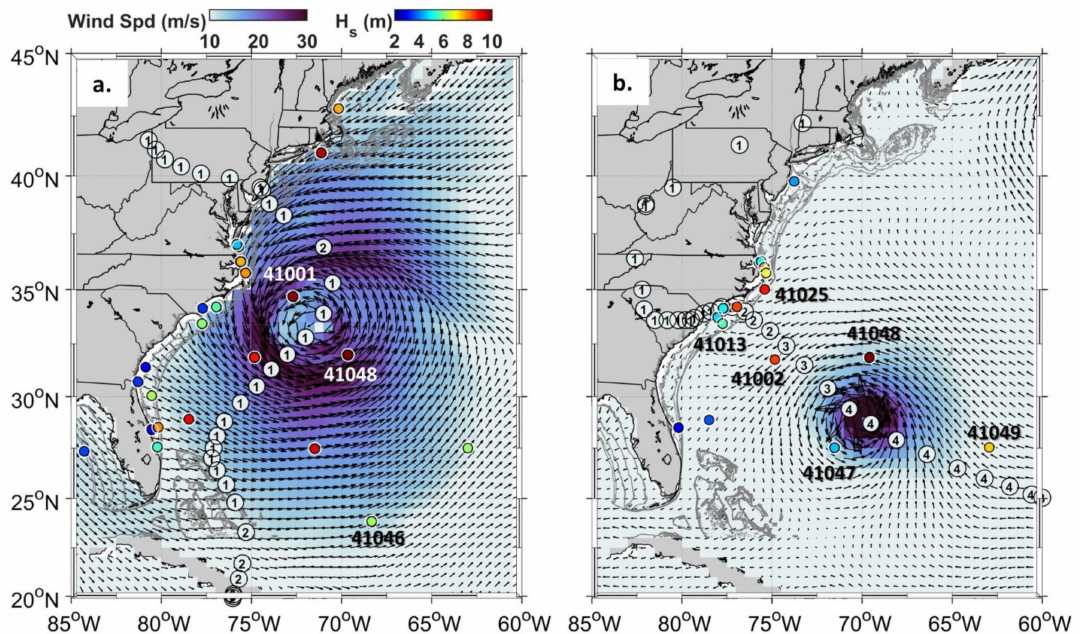
Figure 6. Map of NCEP 30 arcmin global wind product for Hurricanes ( a ) Sandy at 20:30 UTC on 2012 October 28 and ( b ) Florence at 09:00 UTC on 2018 September 12. Each figure was overlaid with the modeled wind vectors (black arrows) for each storm. The blue-white color scale represents the intensity of the wind. The color scale provided at each buoy location denotes the maximum observed Hs during the storm at that buoy location. TC track bubbles contain storm category (Saffir-Simpson scale) at that